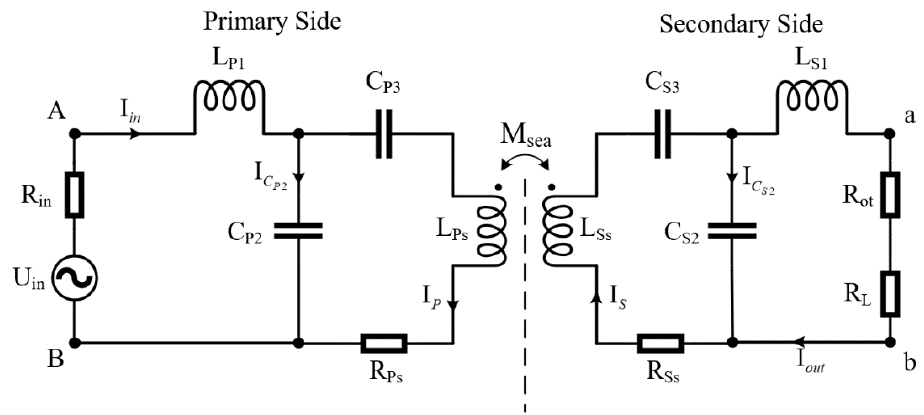
Figure 5. Double-sided LCC compensation topology for underwater WPT system.